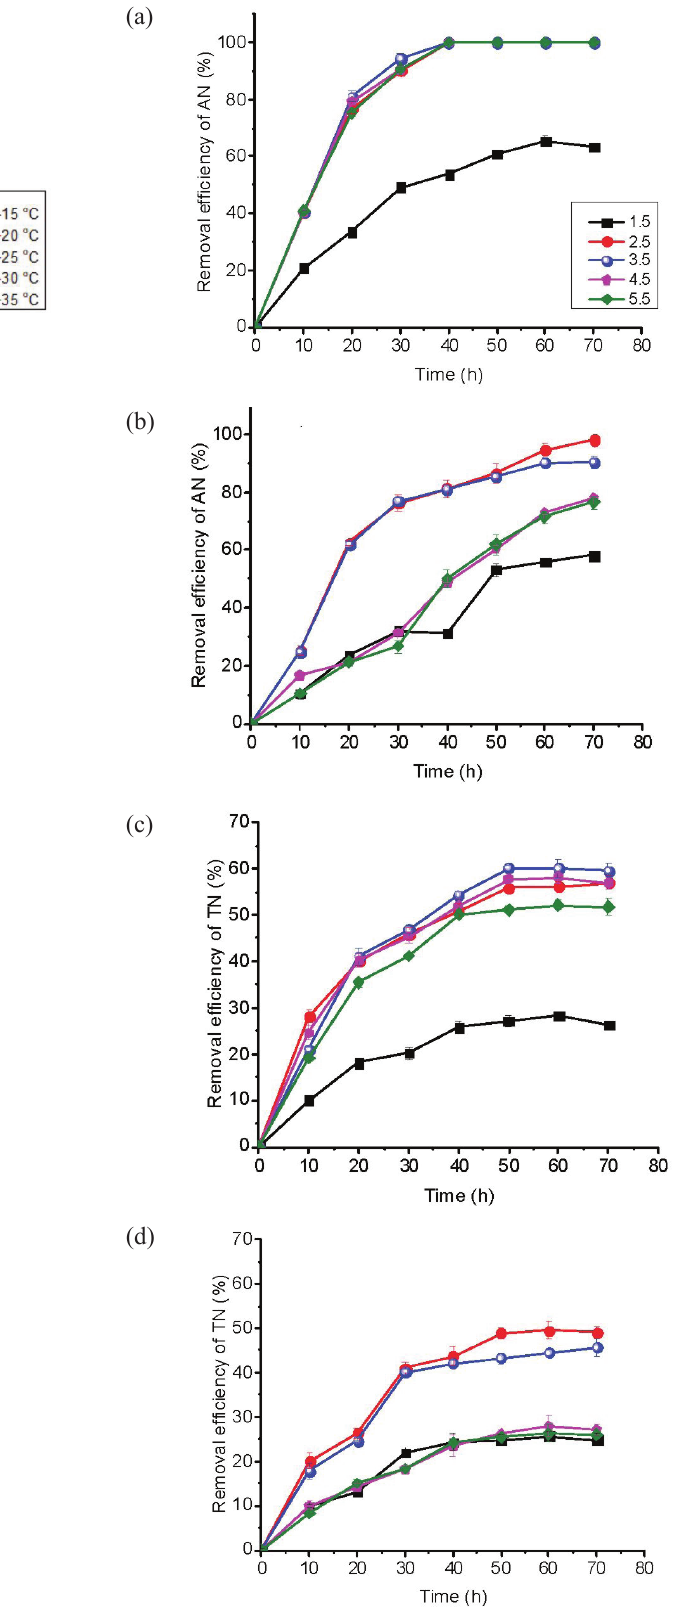
Fig. 5 – Effect of temperature on AN removal by immobilized microorganism (a) and free microorganism (b) and effect of temperature on TN removal by immobilized microorganism (c) and free microorganism (d)